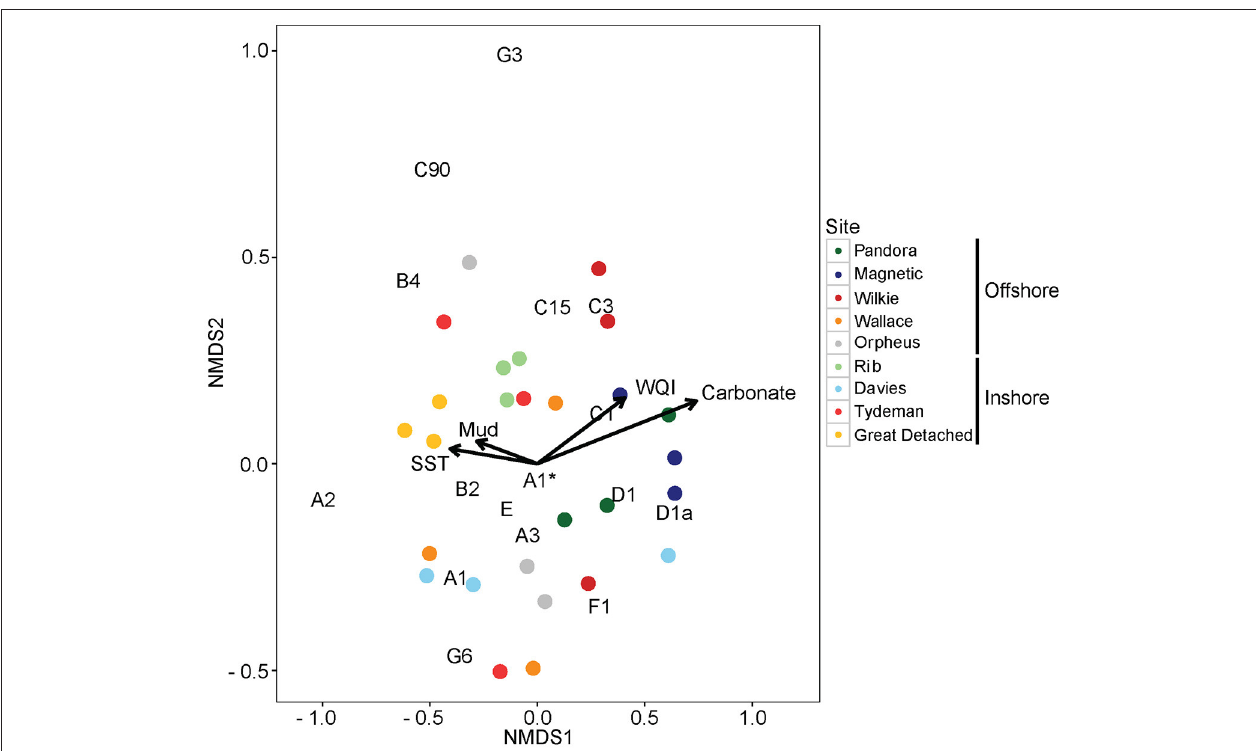
FIGURE 9 | Nonmetric multidimensional scaling (NMDS) of variance-normalized Symbiodinium type abundances (summed OTUs that belong to the same type) in pre-experimental sediment samples using Bray-Curtis distances. Northern sediments are in yellow and red, and central sediments are in gray, blue and green colors. Inshore and offshore sediment samples are in dark and light hues, respectively. Environmental covariates (mud, carbonate, Sea Surface Temperature, and Water Quality Index) are overlaid as vectors. Large vector values for mud and carbonate represent low percent mud and carbonate (see Materials and Methods). Symbiodinium types in black are also overlaid onto the ordination space. As an example, high normalized abundances of types D1 and D1a correspond to high mud content (i.e., low vector values of mud). A1* is equivalent to S. natans